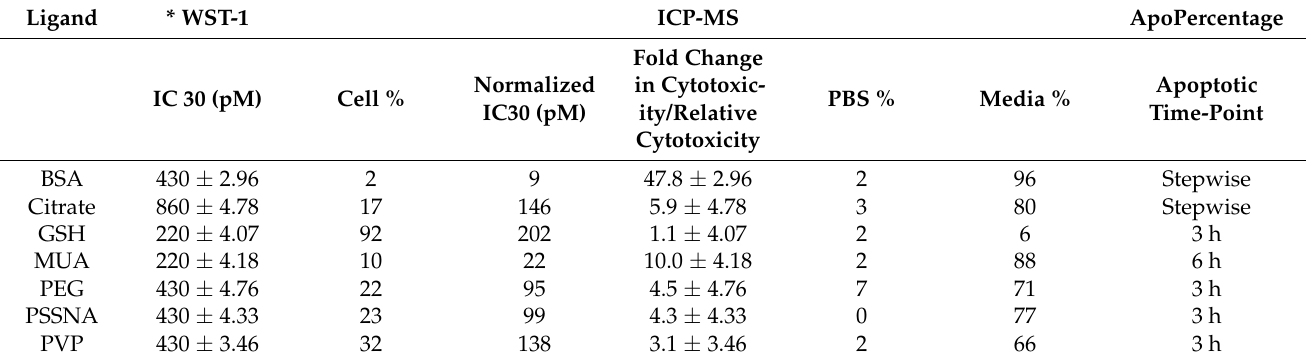
Table 2. Cytotoxicity and cell entry of